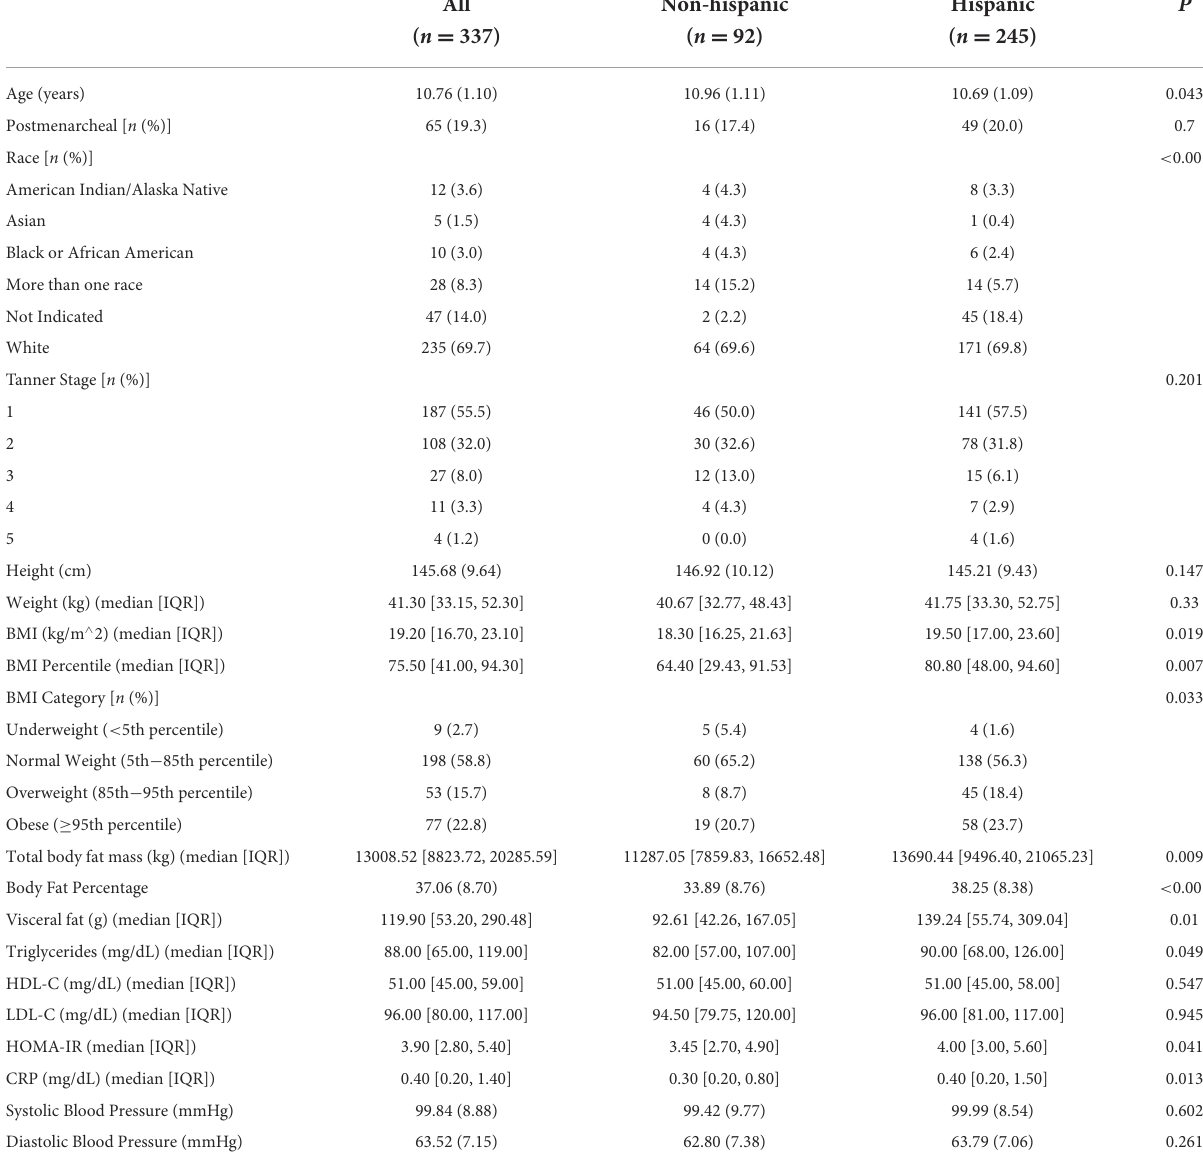
TABLE 1 Sample characteristics of girls with complete data in the STAR study ( n = 337). All